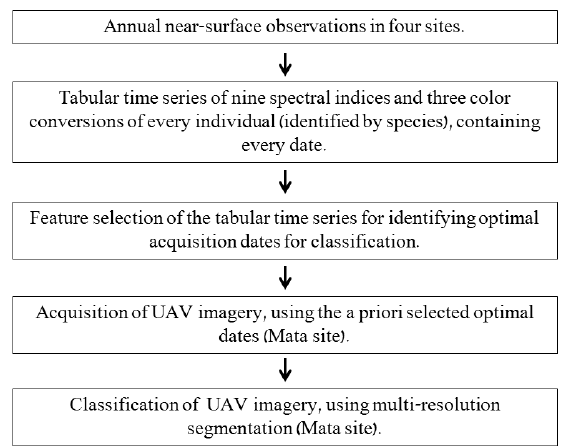
Figure 5. Schematic description for the process of identification of optimal dates for species classification from near-surface annual time series, and its contribution for optimizing following UAV data acquisition and classification.